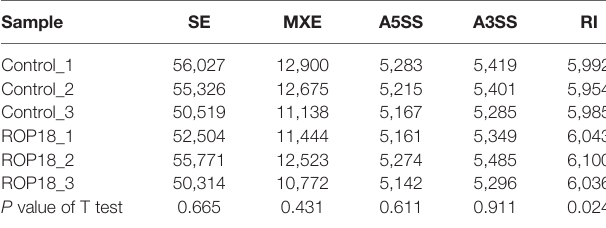
TABLE 1 | The number of alternative splicing events in ROP18-expressing compared to non-expressing (control) HEK239T cells.